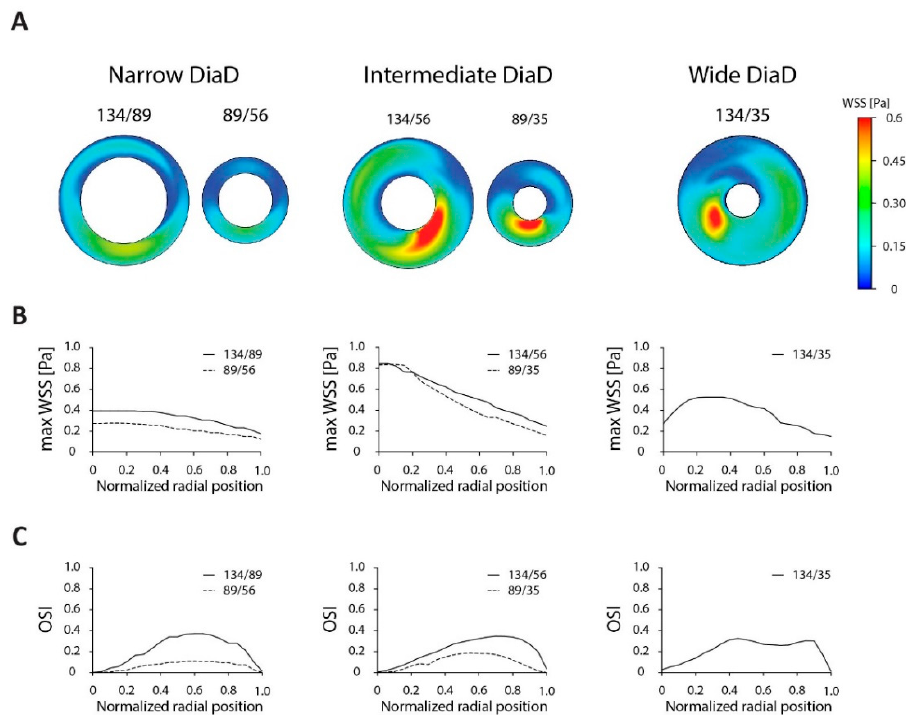
Figure 3. The effect of annular dish design on the distribution of wall shear stress. ( A ) Graphical representation of the shear stress distribution of different annular dish designs. The dish size is scaled to actual size. Dish dimensions are written as outer/inner dish diameter in millimeters. The graphical shear stress distribution scales to maximal 0.6 Pa to display the distributions in all designs. For the calculations, a 3-mm fluid height, 200-rpm rotational speed and a 10-mm orbit was used. ( B ) Maximum shear stress levels as a function of the radial position in the annular dish. ( C ) OSI as a function of the radial position in the annular dish.